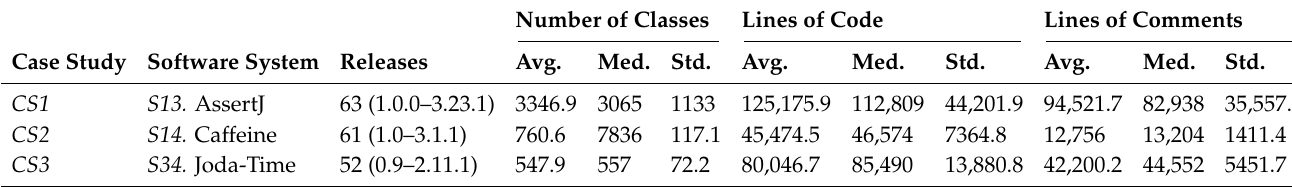
Table 5. Overview of subject software systems included in the study (RQ2.2).